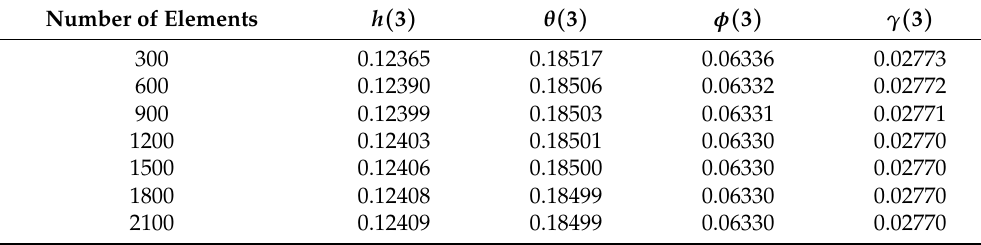
Table 1. Convergence results of the finite element method (FEM) ( Pr = 1, M = σ = β = 0.2, λ 1 =